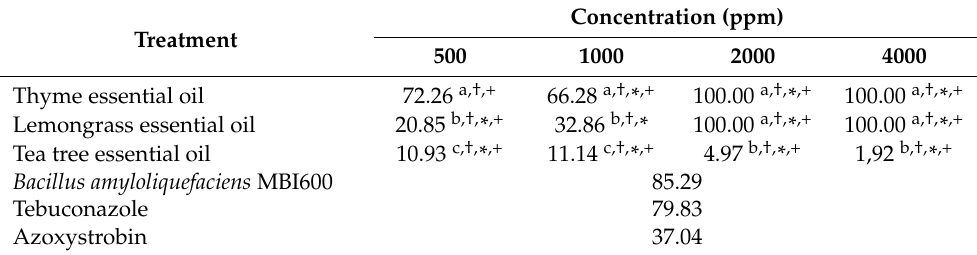
Table 2. Effect of essential oils on mycelial growth inhibition (%) of Alternaria linariae . Treatment